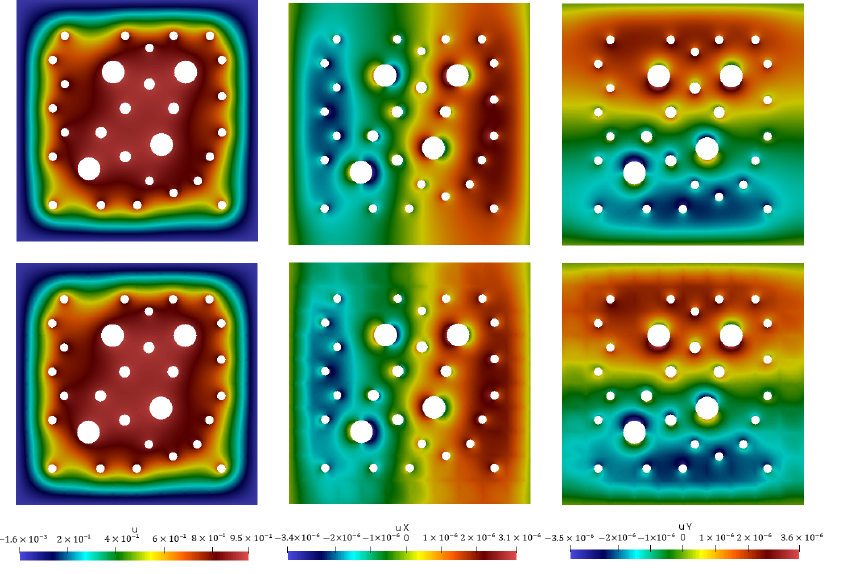
Figure A6. Thermoelasticity problem. Case 2 (homogeneous boundary condition for elasticity and non-homogeneous boundary condition for temperature on perforations). First column: temperature. Second column: displacement of X-component. Third column: displacement of Y-component. First row: Reference solution ( DOF h = DOF u row: Multiscale solution with 24 multiscale basis functions, e ( u ) L 2 = 5.023% and e ( T ) L 2 = 0.374% ( M u g = M u p = M T g = M T p = M = 24, DOF H = DOF u = DOF T H